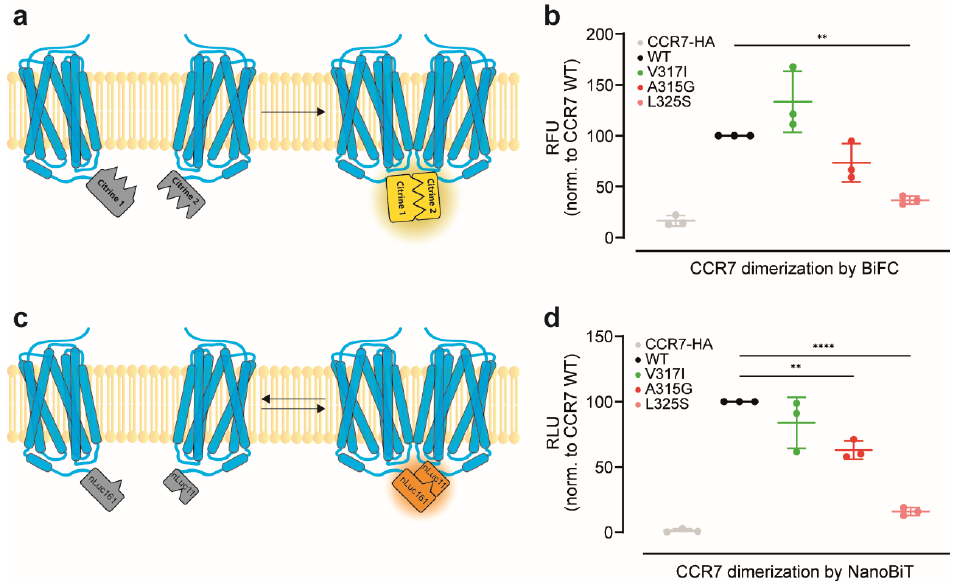
Figure 1. Differences in the dimerisation states of CCR7 and point mutants thereof: ( a ) schematic overview of the split-citrine complementation assay. Upon CCR7 dimerisation split-citrine complements and emits fluorescence upon excitation. Split-citrine complementation is relatively stable and essentially locks the fused proteins in their dimeric form; ( b ) dimerisation states of human CCR7 variants assessed by BiFC. Fluorescence of complemented split-citrine 1 and split-citrine2 each fused to variants of CCR7. HeLa cells were transiently transfected with CCR7 wild-type (WT), the CCR7 SNP V317I, or the CCR7 dimerisation-defective A315G and L325S mutants each fused to the split-citrine halves. CCR7-HA served as negative control. Relative fluorescence units (RFUs) for each receptor pair were normalised to CCR7 WT; ( c ) scheme of the split-luciferase complementation assay. Due to a micromolar dissociation constant between the split-luciferase subparts, receptor dimerisation remains transient and more dynamic; ( d ) dimerisation states of human CCR7 variants assessed by the split-luciferase complementation assay. Relative luminescence units (RLUs) upon CCR7 dimerisation were determined in transiently transfected HeLa cells. ( b,d ) n = 3, mean ± SD, statistical analysis: one-way ANOVA. ** p < 0.01; **** p < 0.0001.